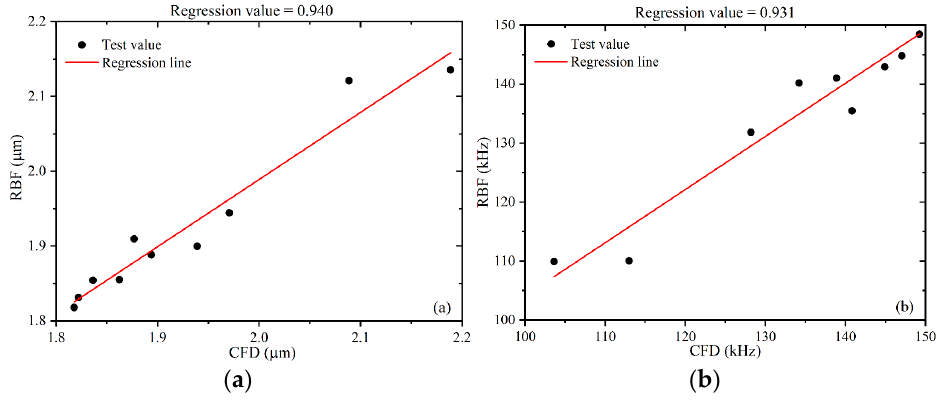
Figure 6. Comparison between prediction and reality: ( a ) D and ( b ) F.